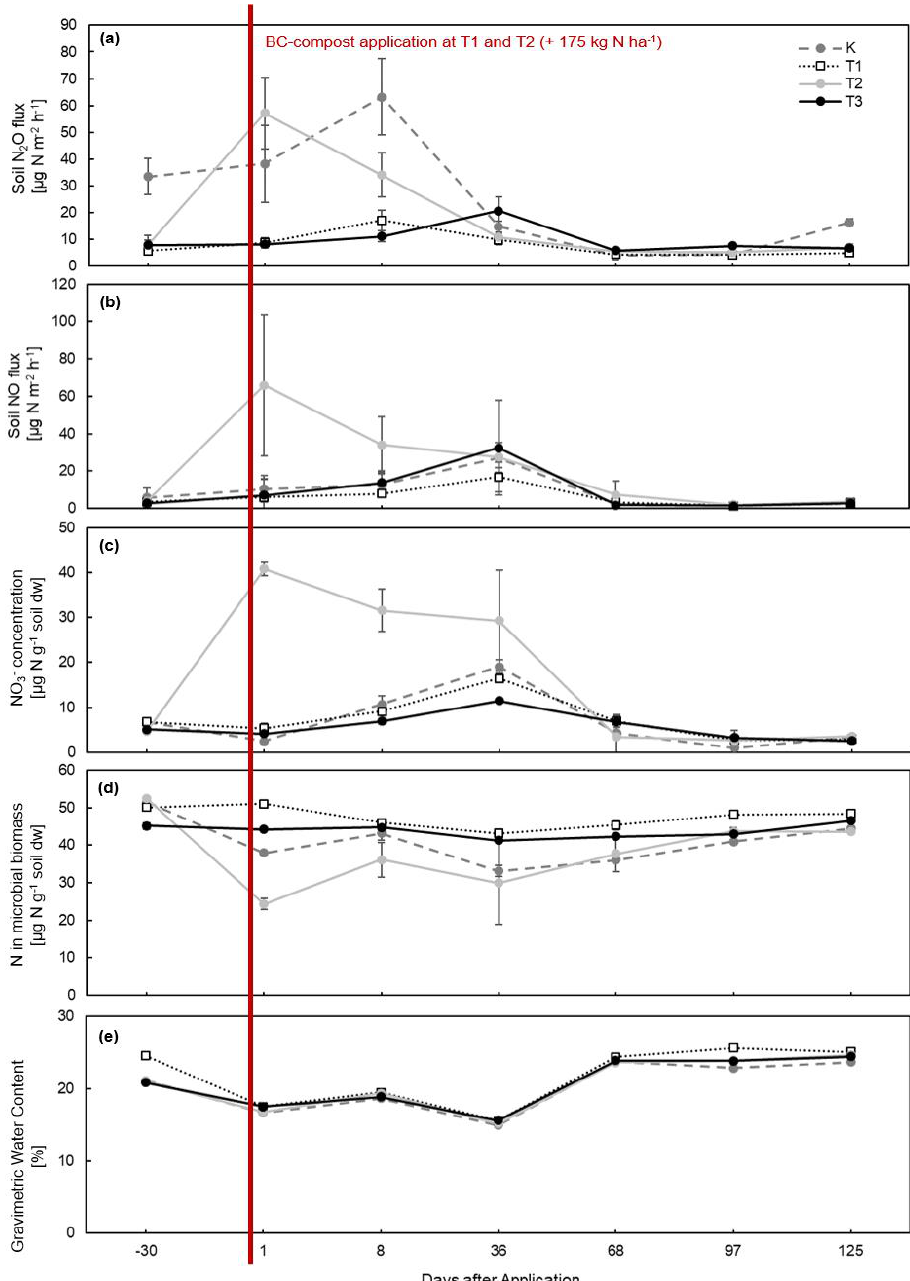
Figure 2. Mean soil N 2 O emissions ( a ), soil NO emissions ( b ), NO 3 − concentration ( c ), N in microbial biomass ( d ), and gravimetric soil water content ( e ) during the field experiment in 2014 (155 days). The red line indicates biochar-compost application at T1 and T2 (+175 kg N ha − 1 ); soil was also disturbed at K and T3. Error bars represent the standard error of mean; n = 3 ( a ), n = 6 ( b ), n = 3 ( c – e ). K—control without BC-compost; T1—1% BC-compost; T—0.5% BC-compost + 175 kg N ha − 1 ; T3—no fresh BC-compost during this field trial.